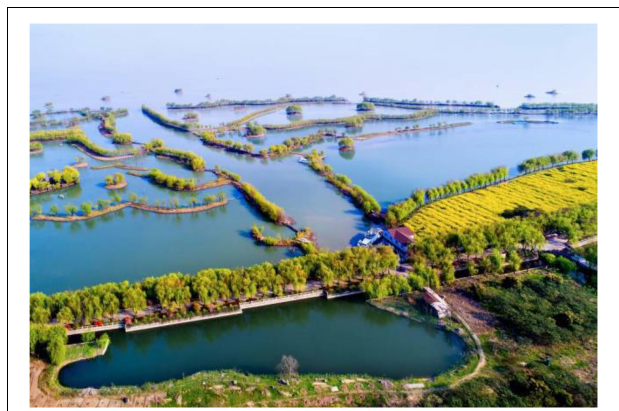
FIGURE 3 | Layered artificial islands in Shanshan National Wetland Park [Source: provided by Suzhou Wetland Protection Management Station (SWPMS)].